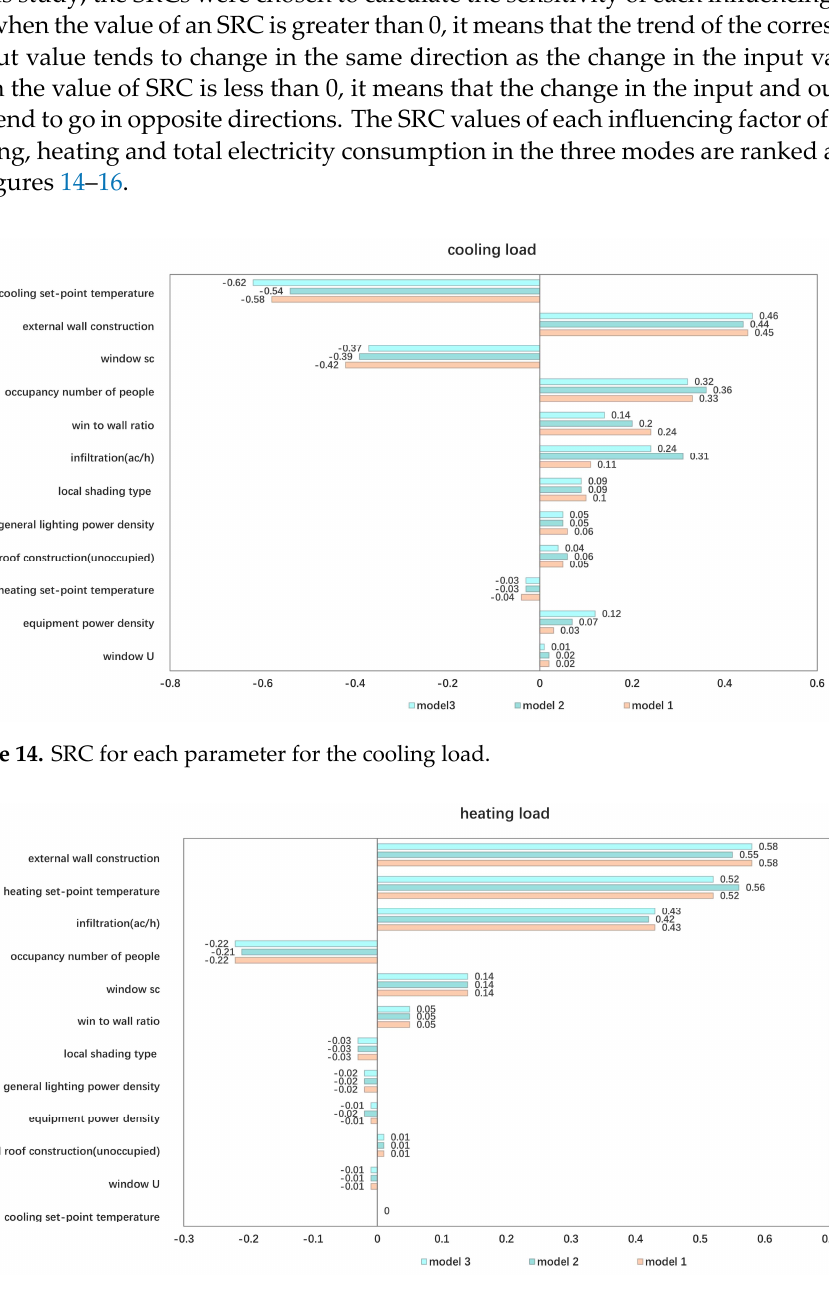
Figure 15. SRC for each parameter for the heating load.